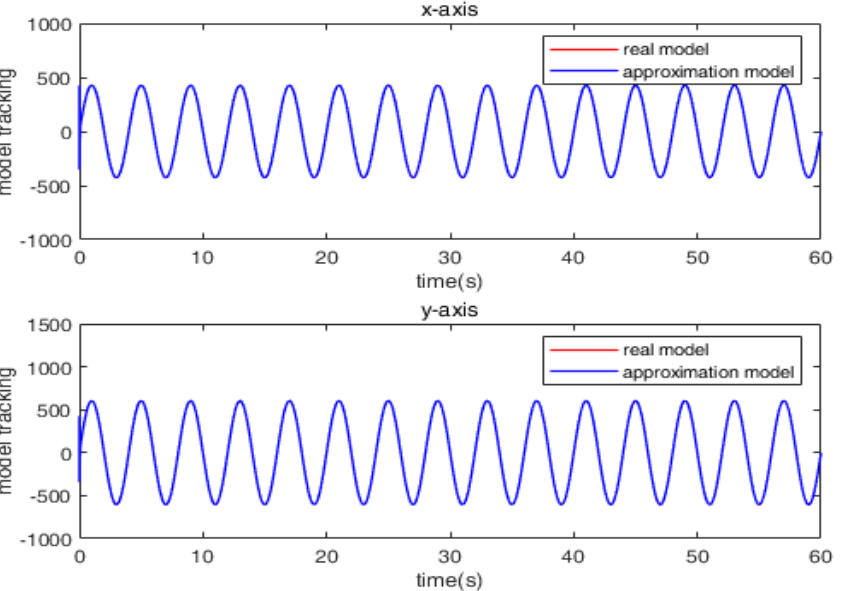
Figure 11. Online approximation under NFTSMC-GRFNN.